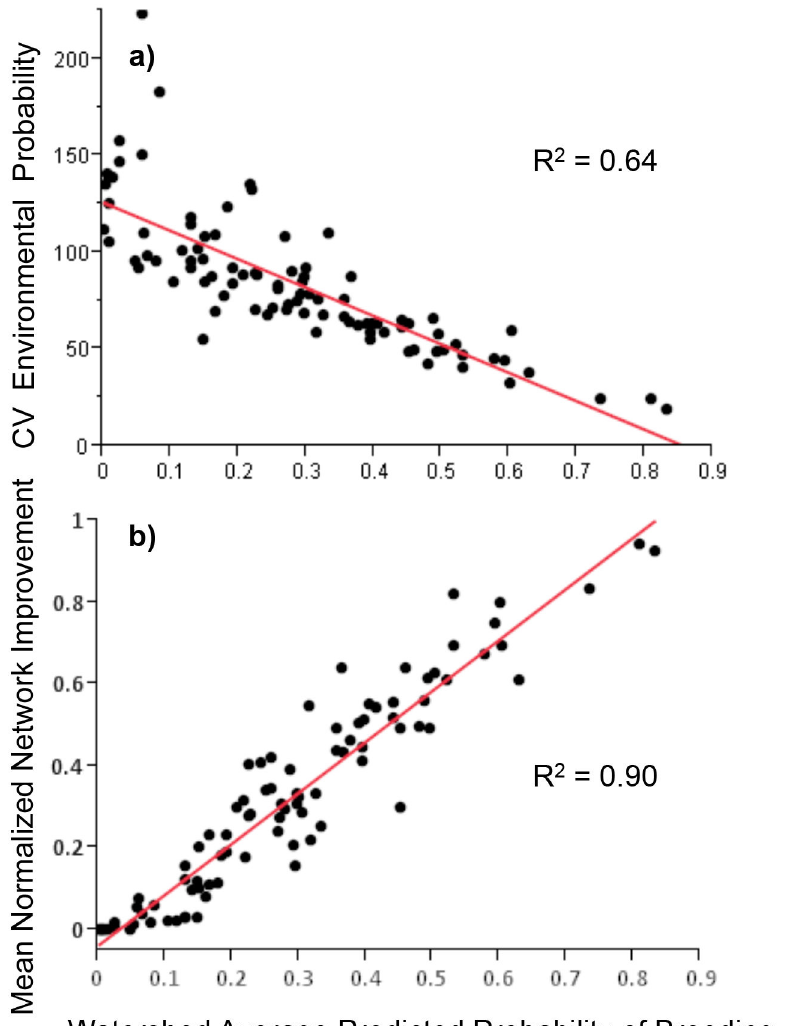
Figure 3. Watershed scale patterns of predicted breeding. a) Watersheds with high mean predicted probability of A. canorus breeding (Environmental Model) tend to have low coefficient of variation (CV) in breeding probabilities among meadows within the watershed. b) Watersheds with high mean breeding probability across also show high normalized network improvement in the predicted breeding probabilities due to spatial clustering of ‘intrinsically good’ meadows. ‘Normalized network improvement’ is the proportional increase in Environmental Model predicted probability relative to the maximum improvement